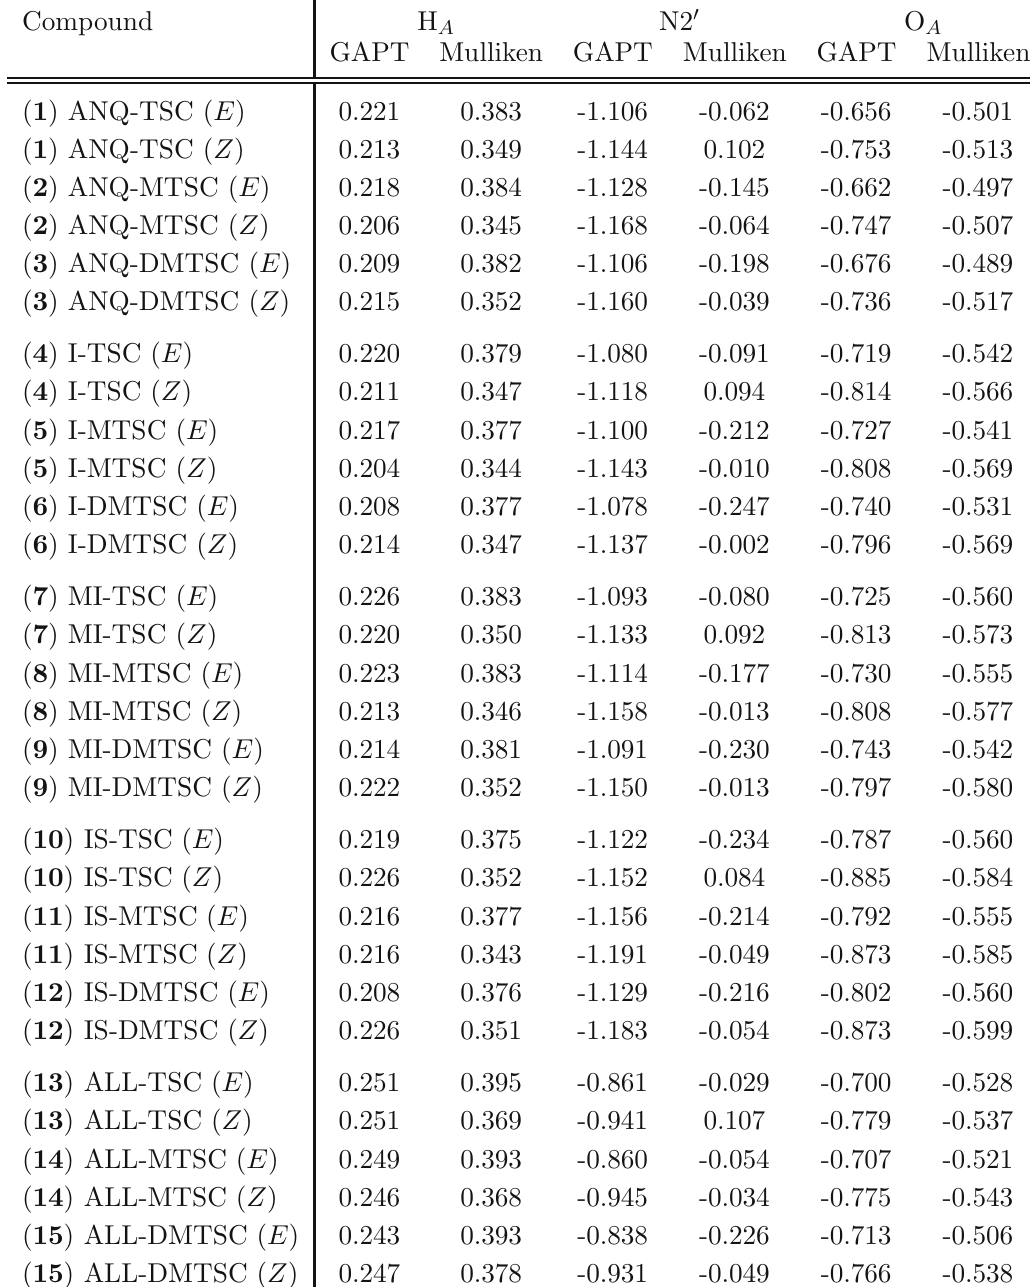
Table 5 Calculated GAPT and Mulliken atomic charges for selected atoms in the inves- tigated